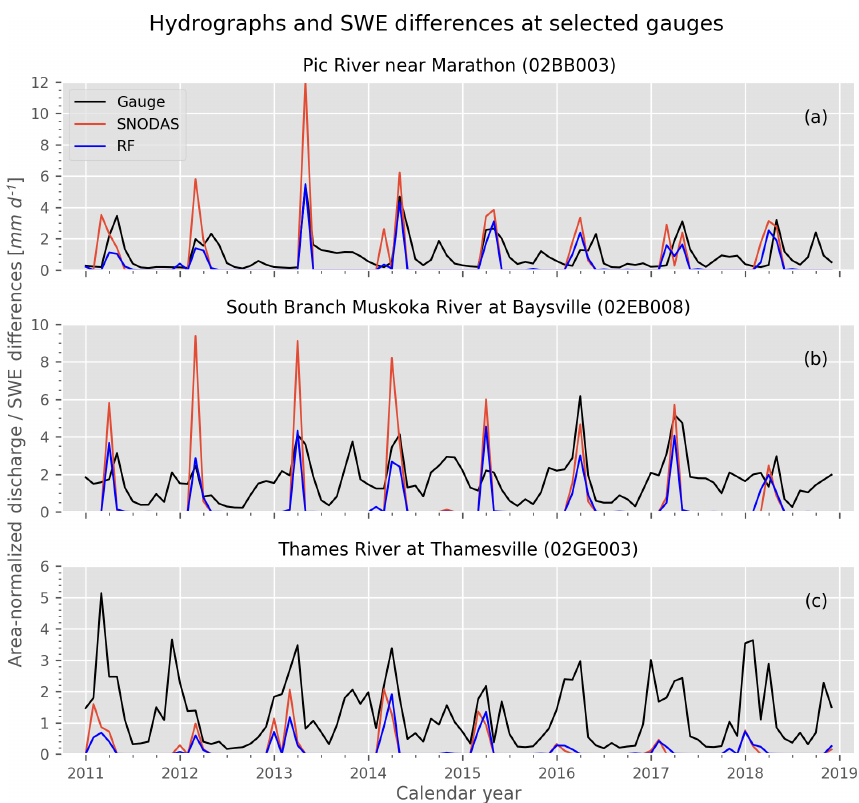
Figure 7. Monthly time series of area-normalized discharge from three river gauges in Ontario, along with corresponding melt estimates calculated from the SNODAS and RF-corrected SWE datasets. Melt estimates are negative monthly SWE differences averaged over the drainage area of the corresponding gauge (see Sect.